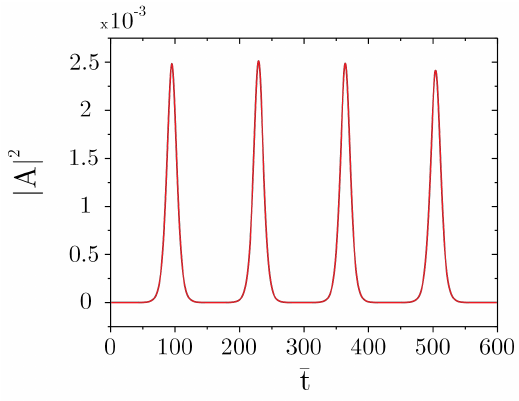
Figure 8. | A | 2 vs. ¯ t for ¯ κ = 0 and ρ = 0.1 and ¯ δ = 1/2 ρ